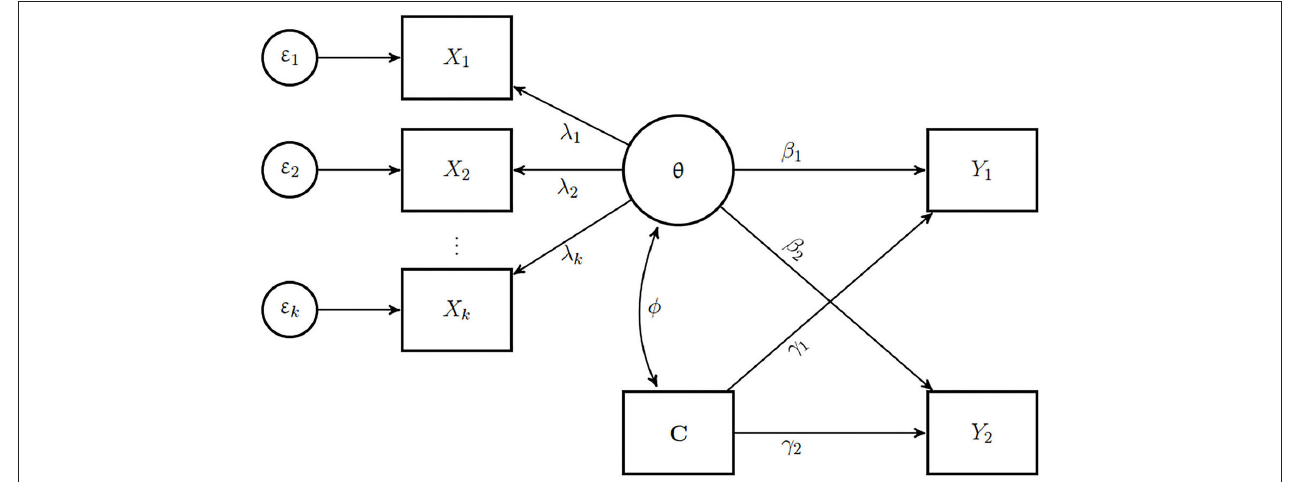
FIGURE 1 | Example of a model used for generating data for the simulation study. The latent skill θ is measured by k manifest items X 1 , ... , X k . The different factor loadings λ 1 , ... , λ k and measurement error terms ε 1 , ... , ε k reflect different degrees to which each item reflects the latent ability. C is a covariate that has a correlation of φ with the skill. Both θ and C are predictors of two outcomes Y 1 and Y 2 . β 1 and β 2 are regression coefficients of θ and γ 1 and γ 2 are the regression coefficients of C for Y 1 and Y 2